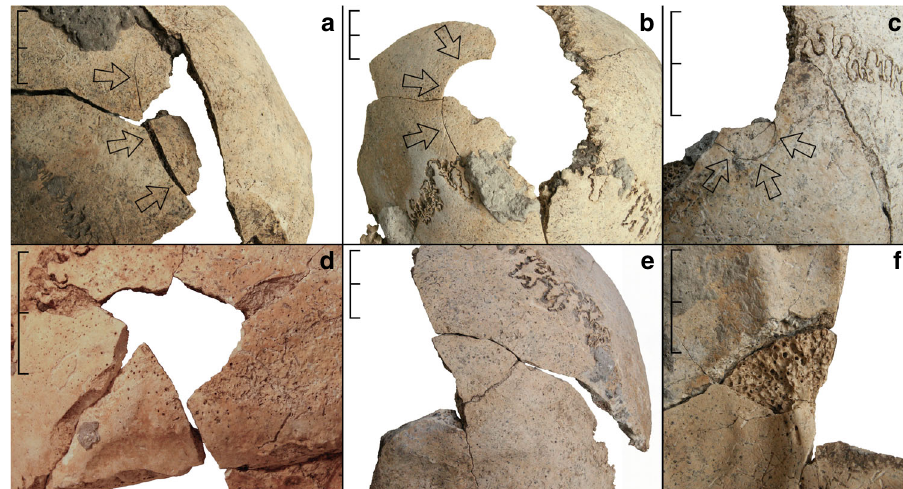
Fig. 2 Examples of cranial perimortem blunt force trauma identi fi ed in the mass grave. a Trauma in the right half of the frontal bone in ind. 4. b Trauma in the left parietal bone of ind. 9. c Trauma in the midline of the occipital bone (near bregma) in ind. 5. d Trauma in the left half of the occipital bone of ind. 7. e , f Trauma in the right half of the occipital bone in ind. 9. Panels a – e in ectocranial view; panel f in endocranial view. Scale bar length is 2